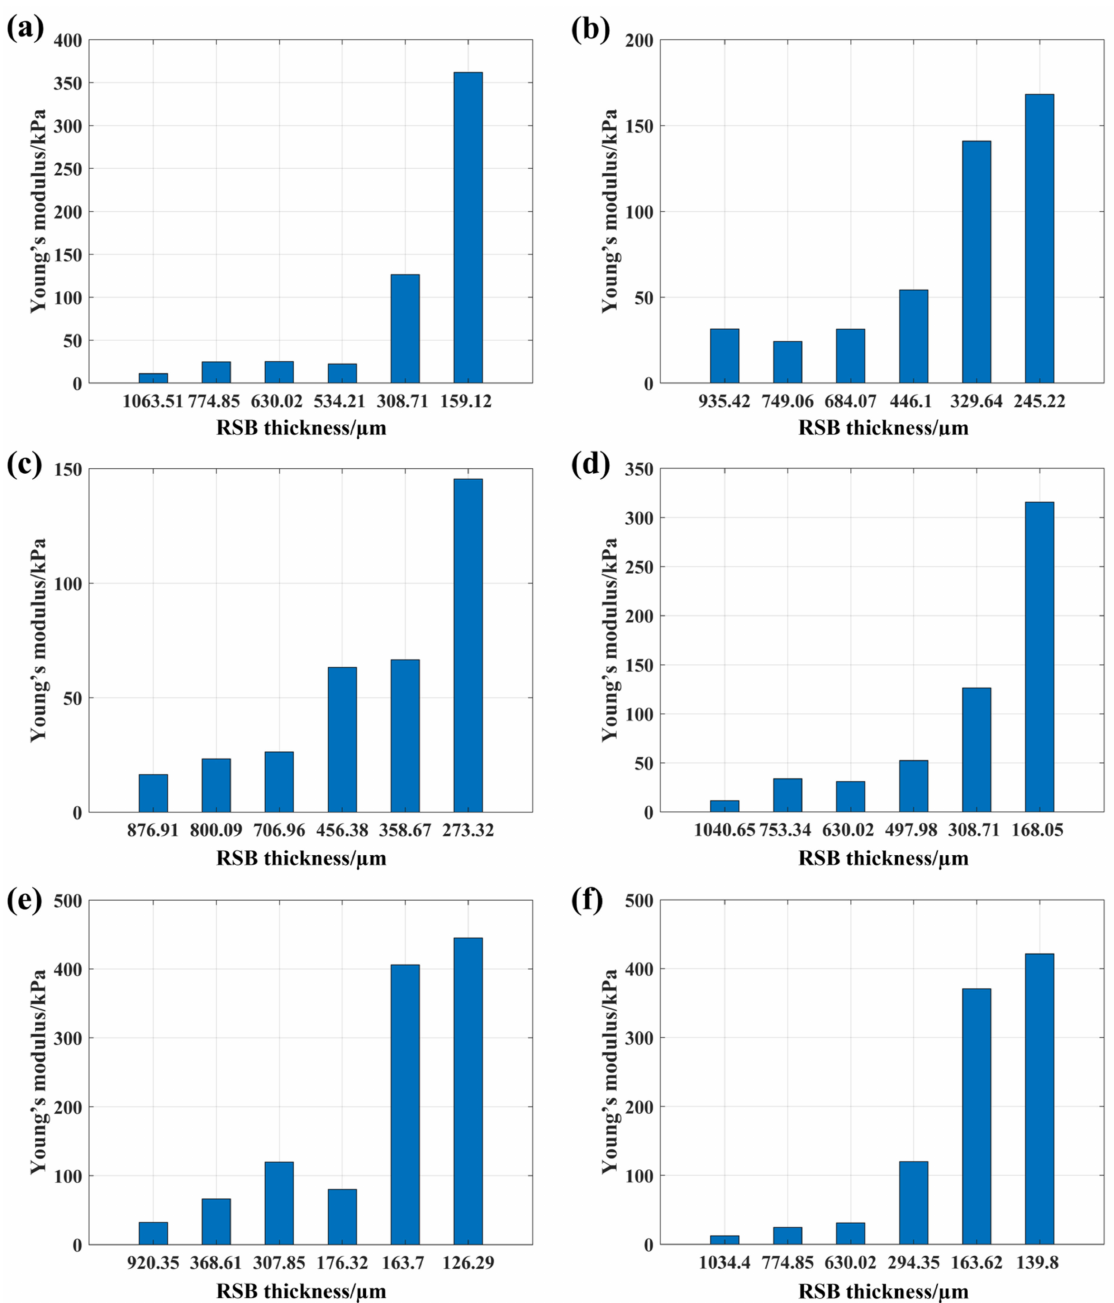
Figure 7. Result of porcine eyes. ( a – f ) Young’s modulus of RSB with different thicknesses in six samples,